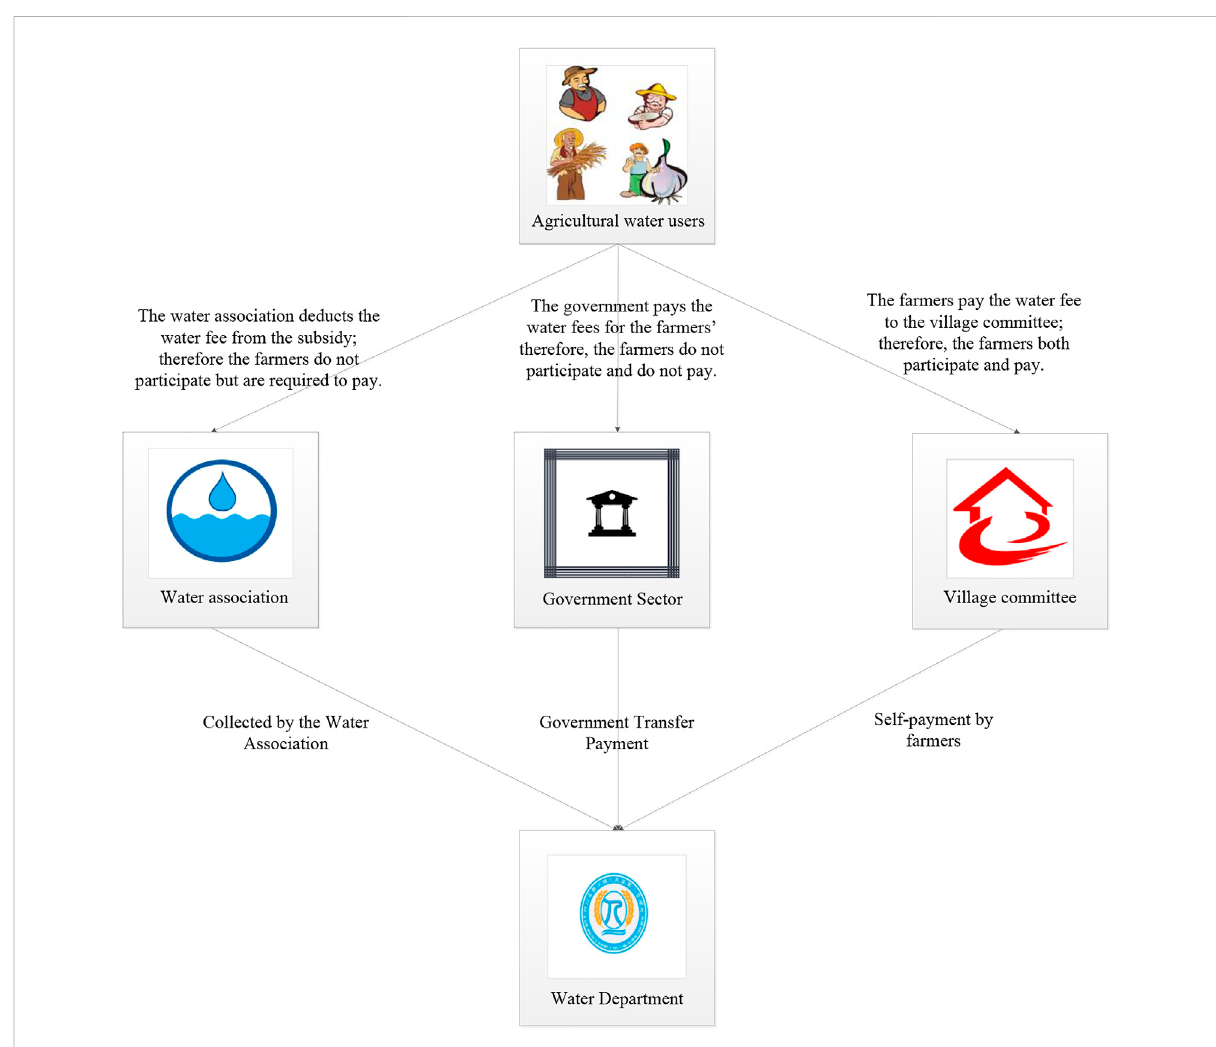
FIGURE 5 Schematic diagram of the water fee charging